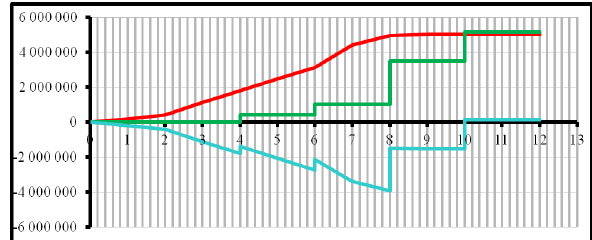
Figure 10: Contractor’s cumulative expenditures, client’s cumulative payments and contractor’s cumulative cash flow for the minimiza- tion of CF max with the priority for works with earlier starting